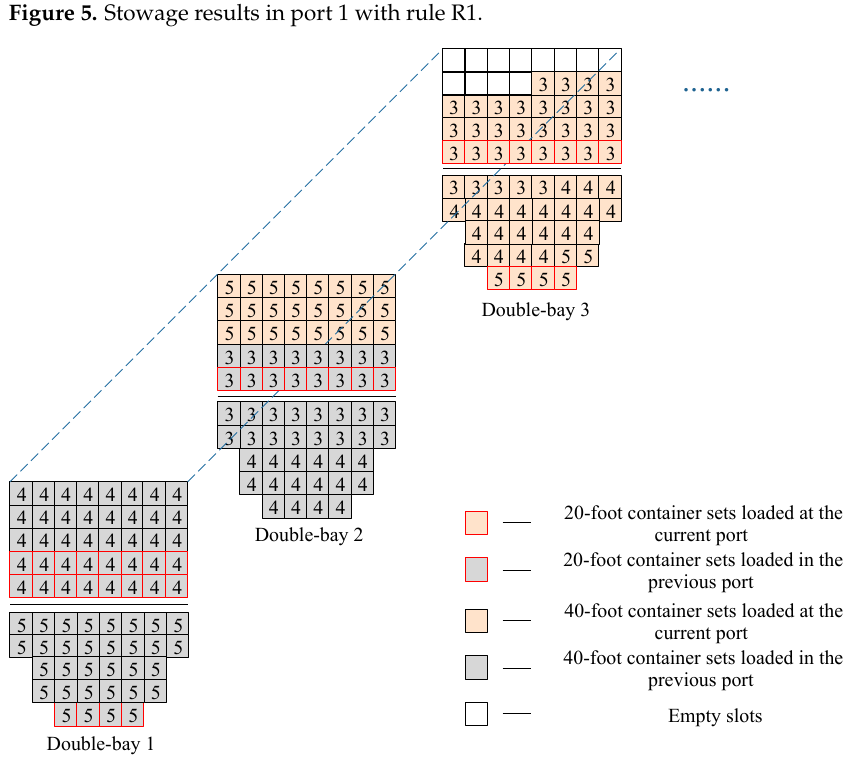
Figure 6. Stowage results in port 2 with rule